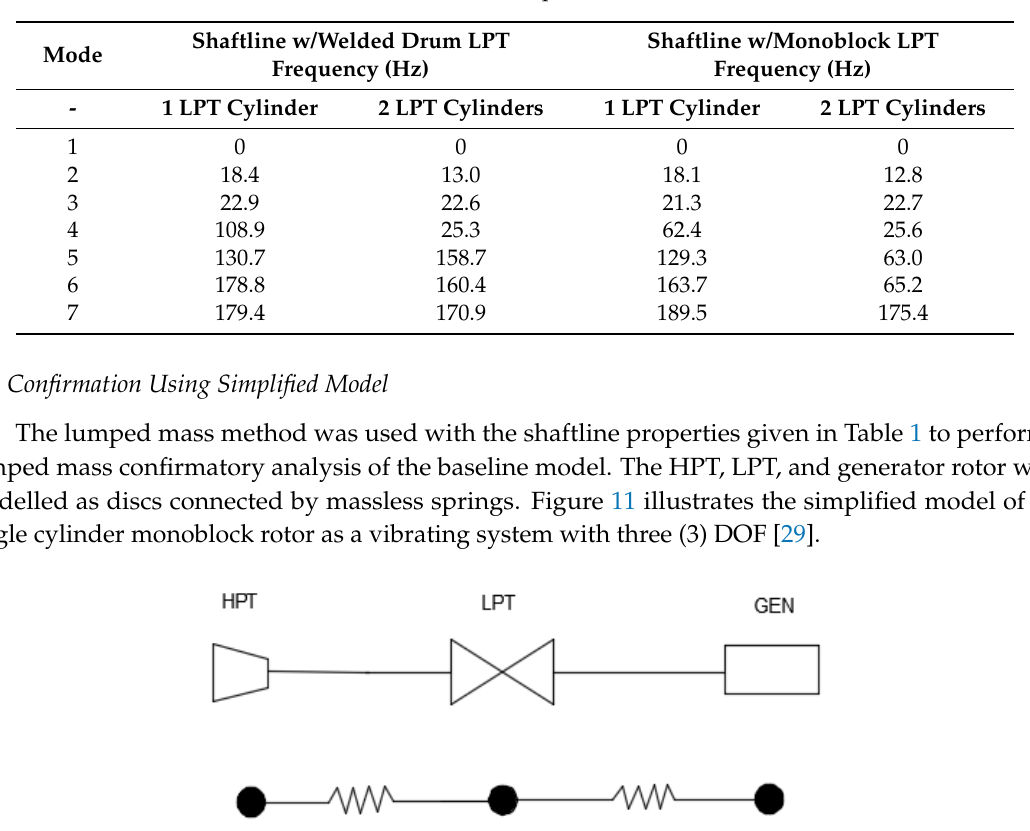
Table 3. Torsional natural frequencies of the shaftline.